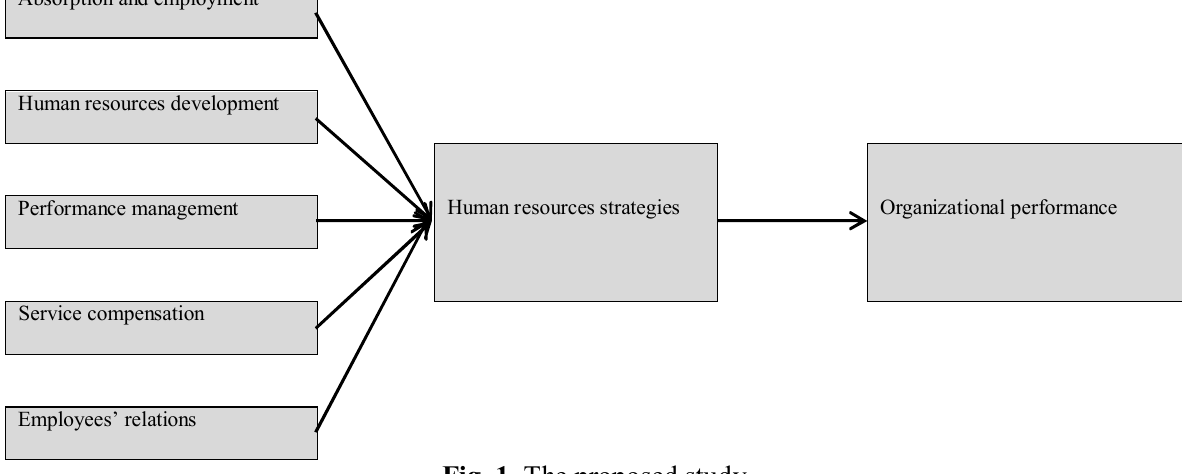
Fig. 1. The proposed